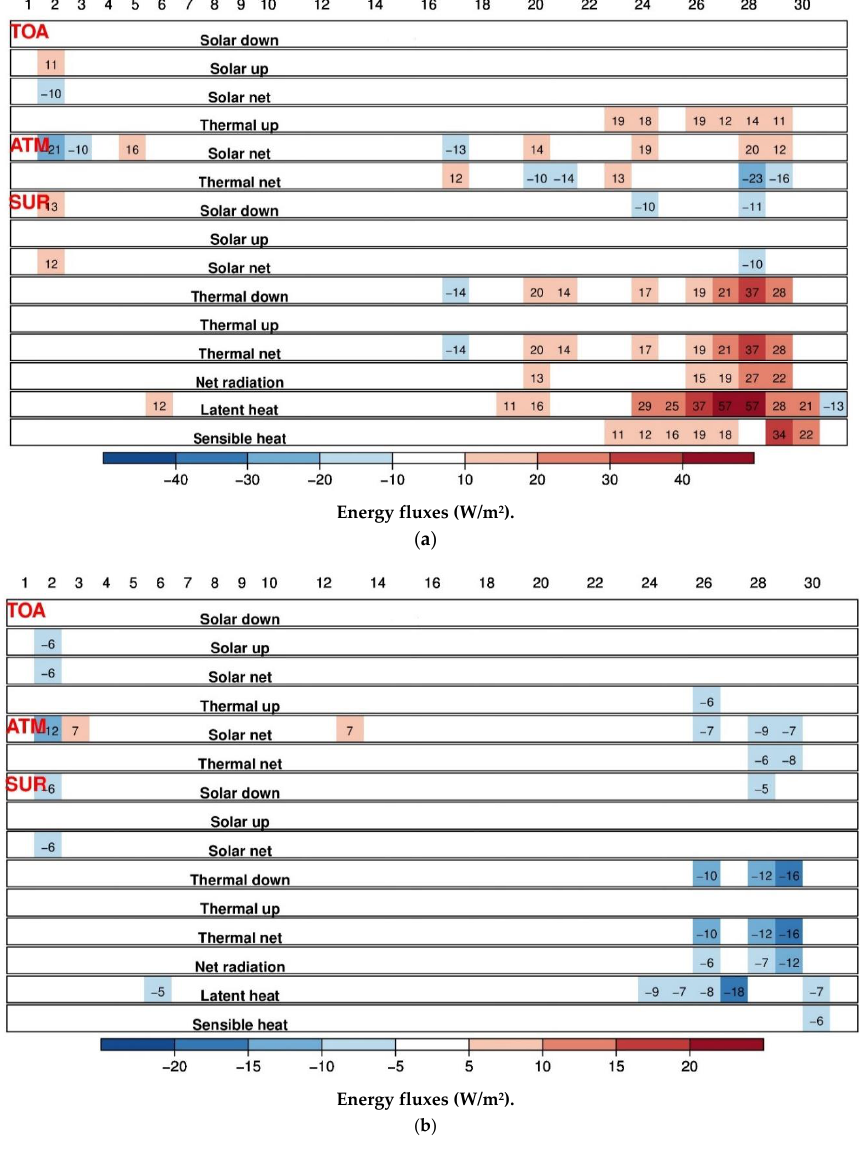
Figure 14. Difference of daily mean energy (W/m 2 ) fluxes (positive upward) at top of atmosphere (TOA), in the atmosphere (ATM) and at the surface (SUR) averaged over the NwgSea area between ( a ) CCLM1 and CCLM4 and ( b ) IV of AHOI ensemble and the stand-alone CCLM ensemble. Time period: 1 – 31 October 2013 (date shown on top of each figure).